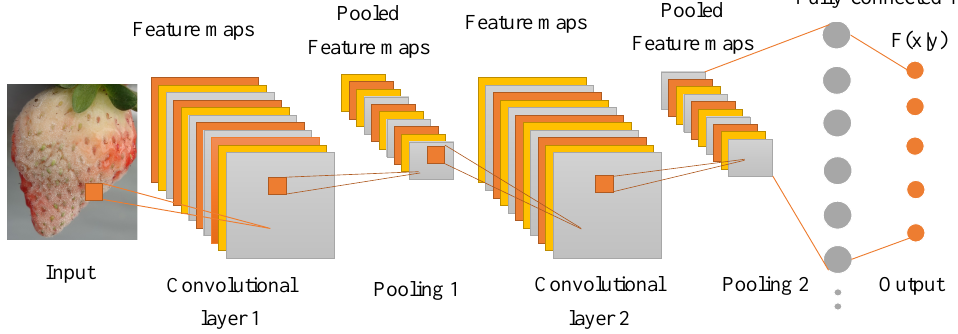
Figure 7. Convolution neural network for the detection of strawberry